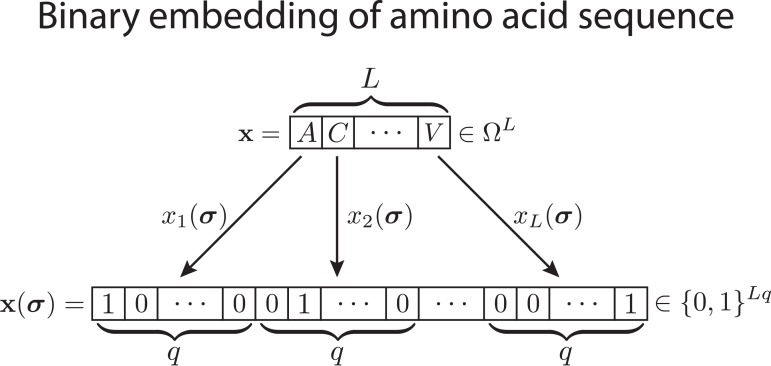
Illustration of binary embedding.The binary embedding 1
σ: Ω → {0, 1}Lq maps each vector of categorical random variables, x∈ΩL, here represented by a sequence of amino acids from the amino acid alphabet (containing the 20 amino acids and one gap element), Ω = {A, C, D, E, F, G, H, I, K, L, M, N, P, Q, R, S, T, V, W, Y, −}, onto a unique binary representation, x(σ)∈{0, 1}Lq.